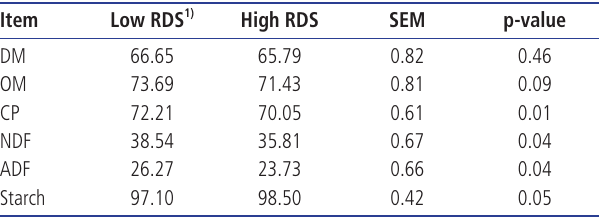
Table 4. Effects of dietary ruminally degradable starch levels on total-tract apparent digestibility in dairy cows Item